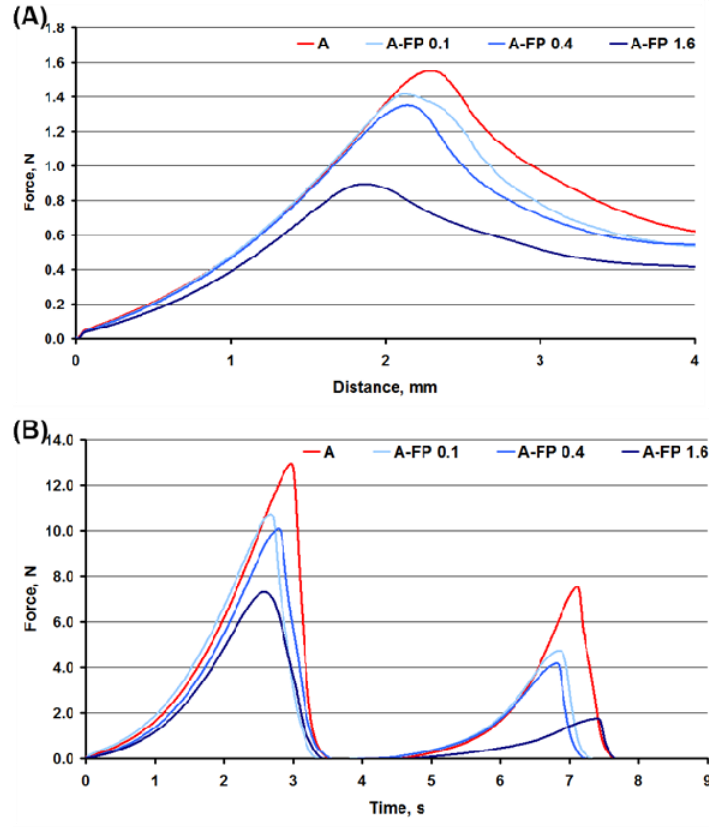
Figure 2. Mean ( n = 12) force over distance ( A ) and over time ( B ) curves in puncture test and double compression tests, respectively, of A and A-FP gels.